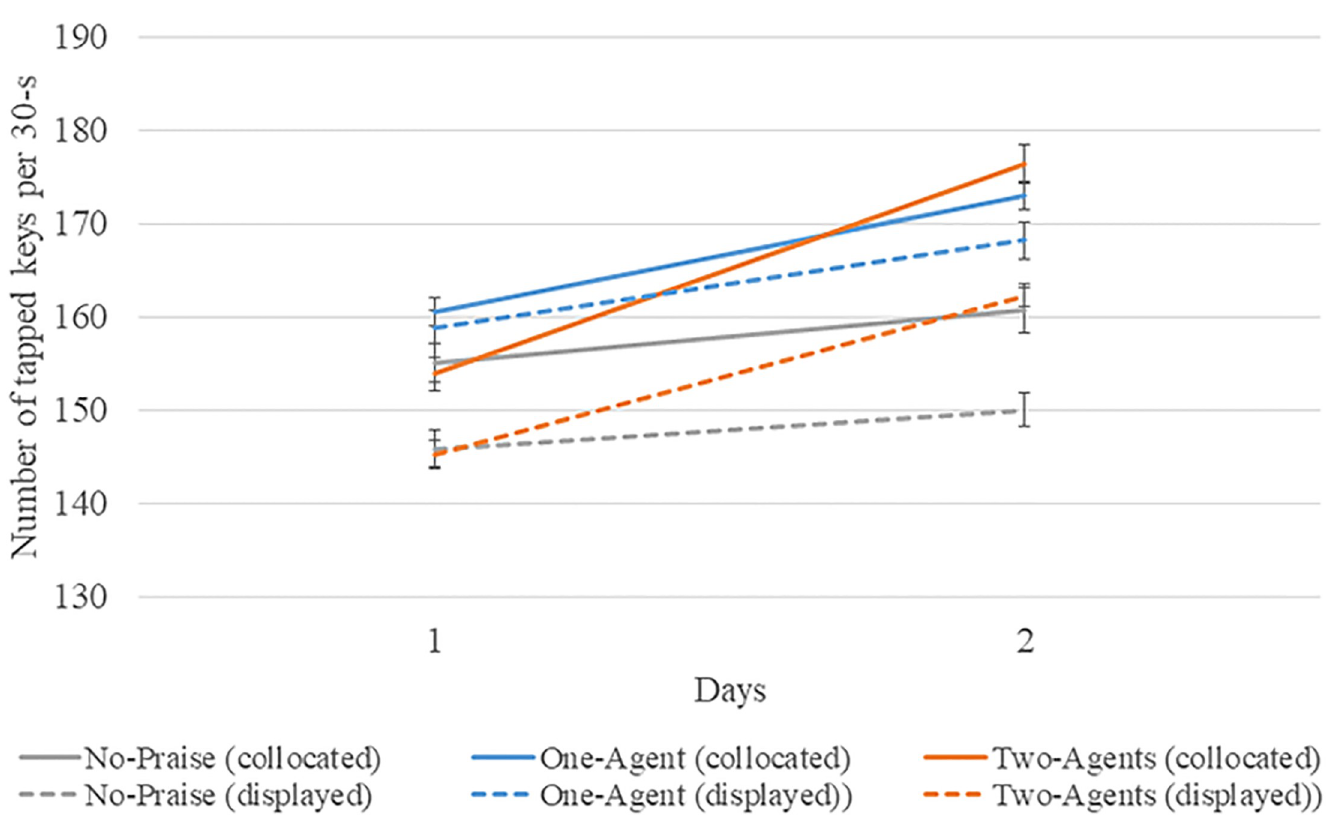
Fig 5. Graph of mean performance of trained sequence (average and